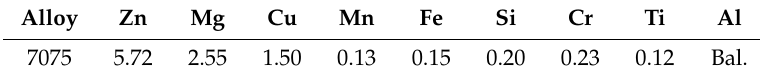
Table 1. Chemical composition of the 7075 Al alloy (mass fraction, %).